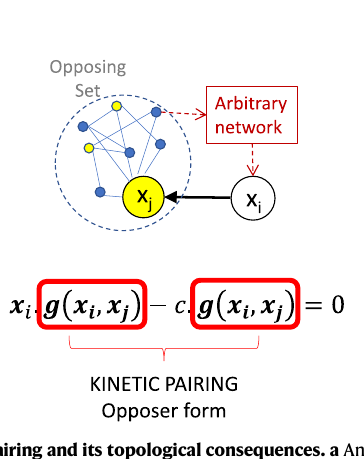
contributions of x j to its own reaction rate are exactly matched (paired) through the pairing function, g ð x i , x j Þ . b A Balancer module has a feedforward structure, whereby two or more distinct pathways connect the diverter node, x j , to the downstreamconnectornode, x i (indicatedingreen).RPAisachievedat x i whenthe upregulating and downregulating contributions of x j to the reaction rate for x i are exactly matched via the pairing function g ð x i , x j Þ